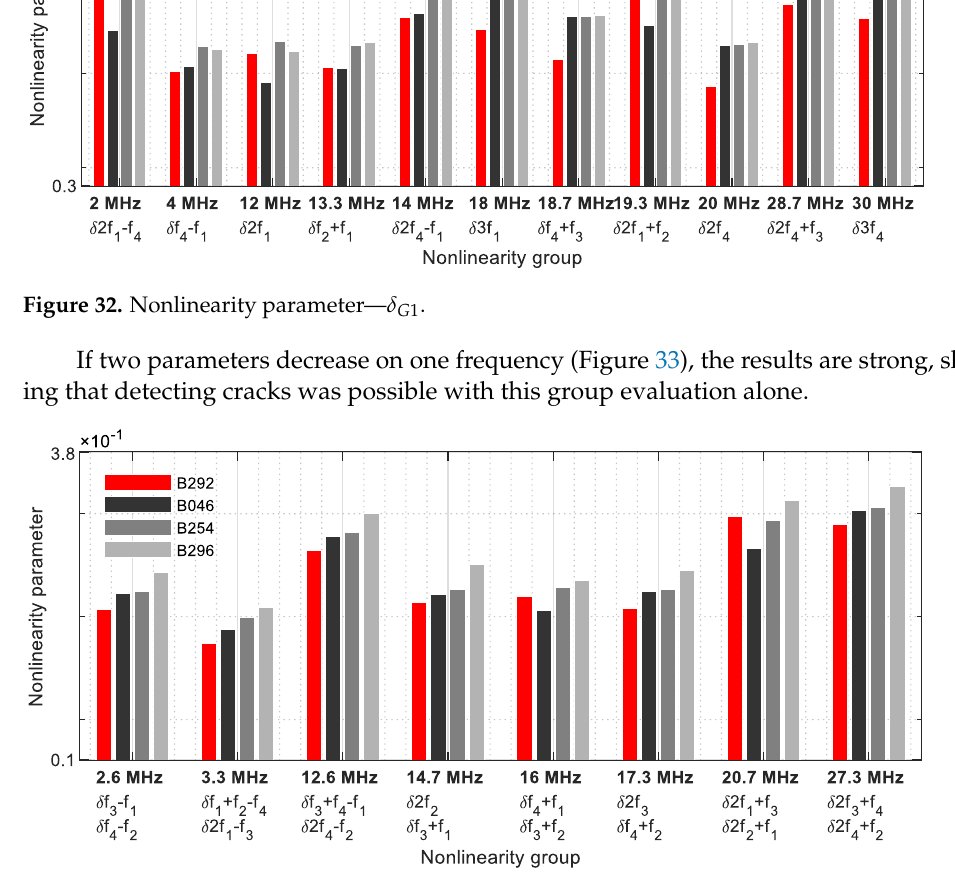
Figure 34. Nonlinearity parameter — δ G3 .